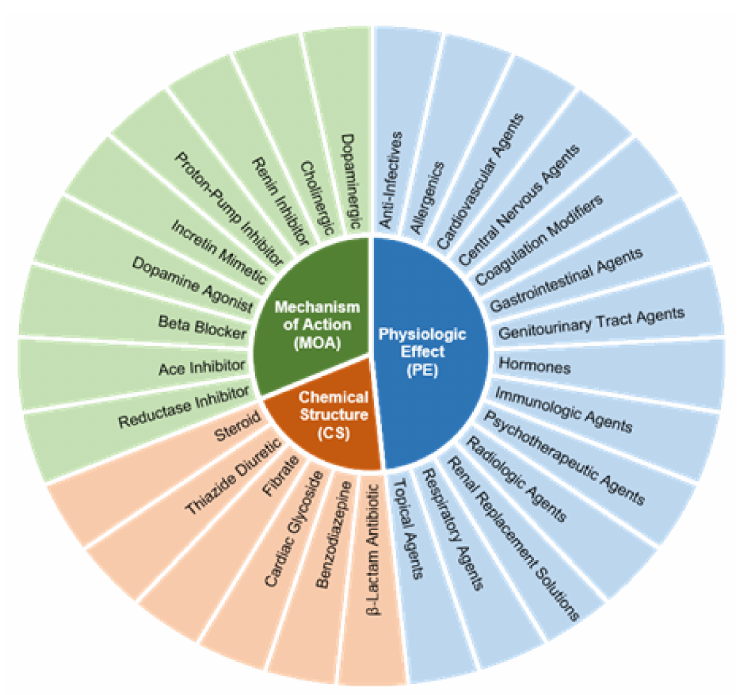
Scheme 2. Illustration of pharmacological classifications and examples of the three